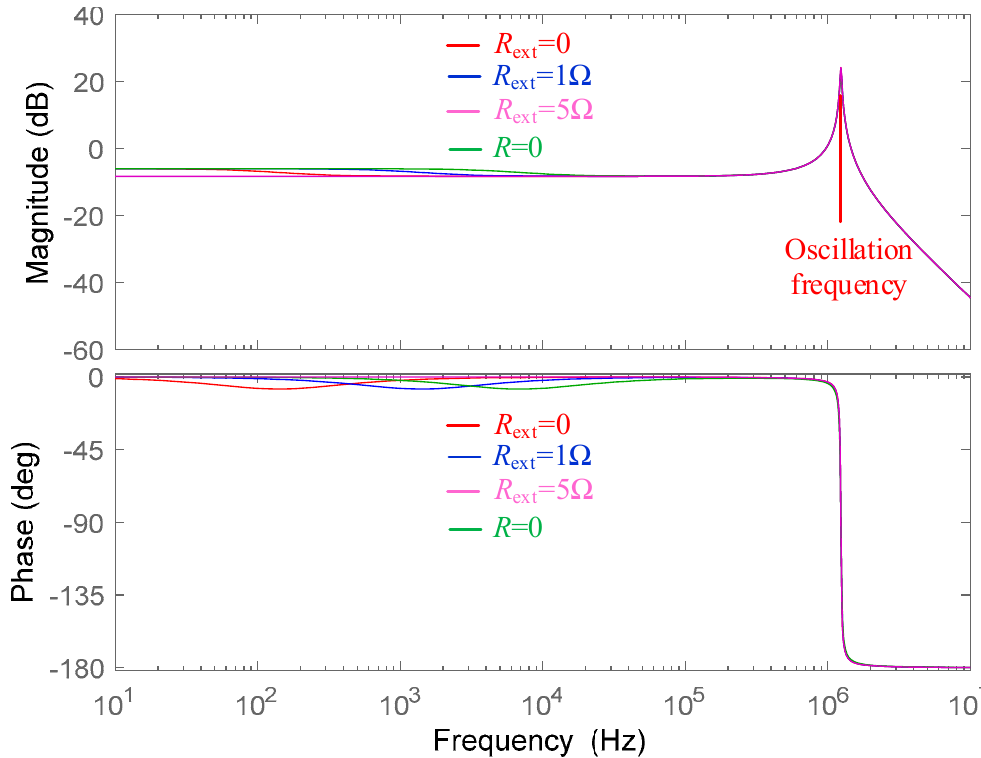
Figure 5. Bode plot of the voltage transfer function with different AC resistances.